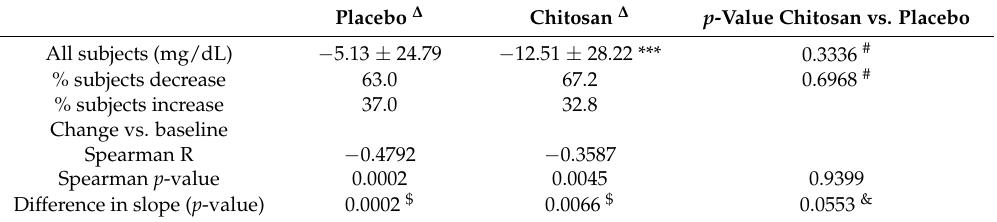
Table 4. Comparison of changes in serum total cholesterol induced by chitosan and placebo treatments. Placebo ∆